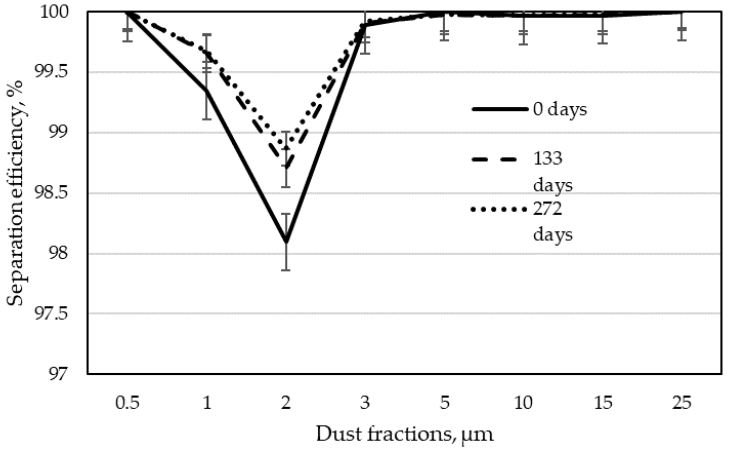
Figure 8. Fractional separation efficiency for filter bags from the dust extraction installation of a narrow surfaces treatment line in particular periods of use.